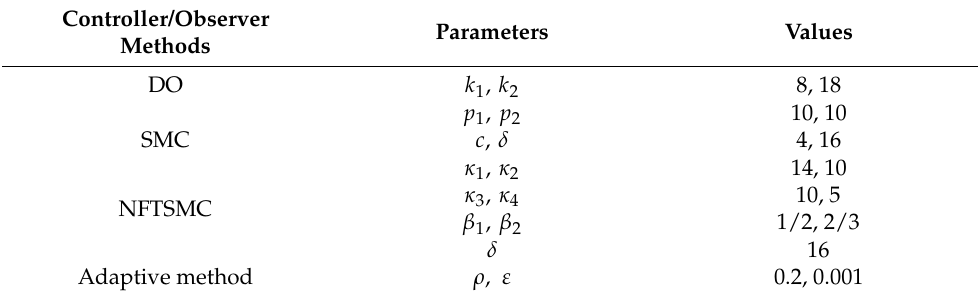
Table 2. The values of the controller/observer’s